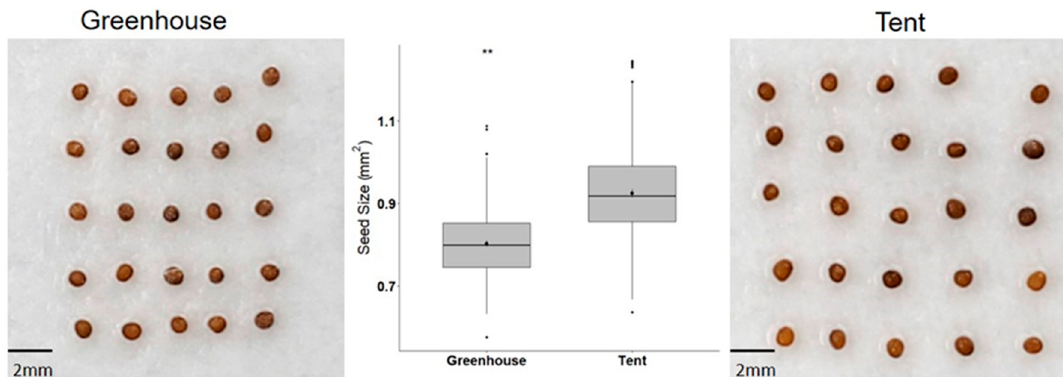
Figure 1. Size of petunia seeds from plants grown in the tent and the greenhouse. Pictures were taken at the same magnification, and ImageJ was used to determine the seed size. The box plots represent the mean ± standard deviation. ** Significant difference between seeds from tent and greenhouse plants at p < 0.01 ( t -test). n = 150 seeds per maternal environment.